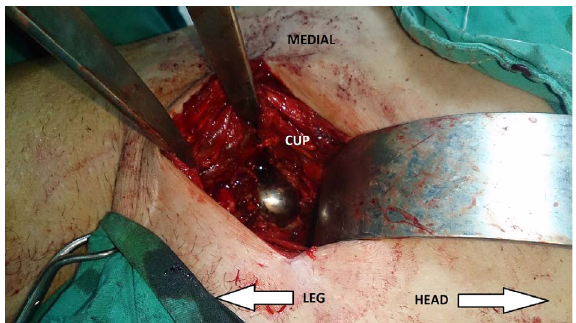
Figure 4. Intra-operative clinical photo of the pararectus approach showing the intra-pelvic cup before extraction.